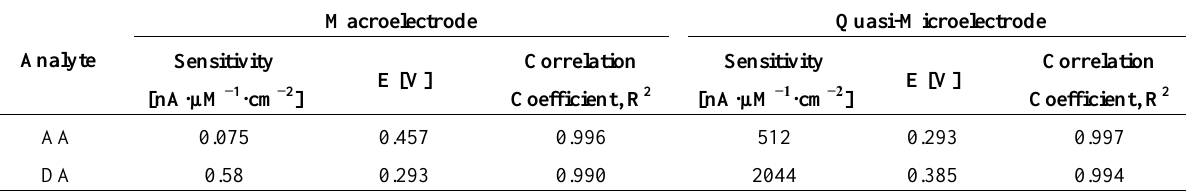
Table 4. Analytical parameters using CV techniques for simultaneous AA and DA detection at SZ-GEC macro and